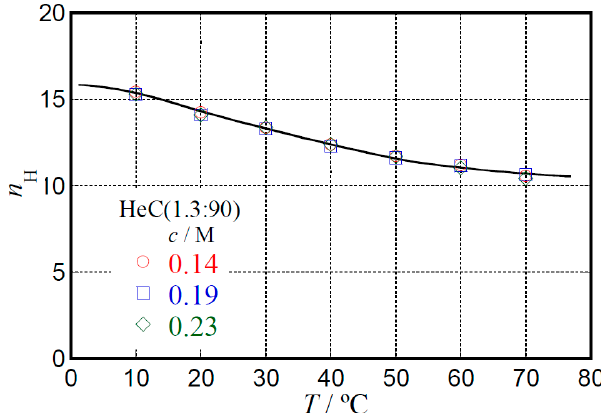
Figure 6. Temperature, T , dependence of the hydration number, n H , per glucopyranose unit for aqueous HeC(1.3:90) solutions at several c values ranged from 0.14 to 0.23 M. HeC(1.3:90) solutions at several c values ranged from 0.14 to 0.23